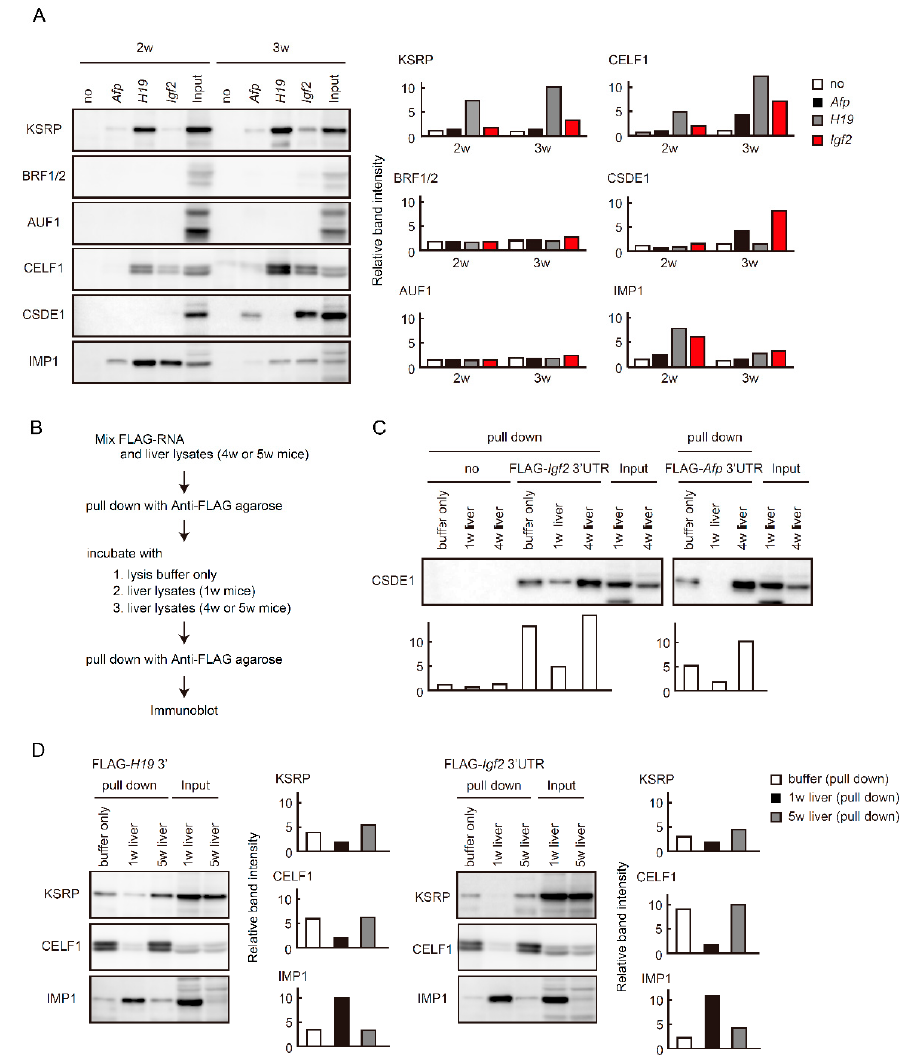
Figure 5. RBPs bind to 3 ′ regions of Afp, H19 , and Igf2 transcripts in a developmental stage-specific manner. ( A ) FLAG-RNAs were incubated with liver lysates from 2 w or 3 w mice. FLAG-RNA-protein complexes were purified and analyzed by immunoblot analyses. Right graphs show quantification of immunoblot data. Relative band intensities to inputs (2 w or 3 w) are calculated ( n = 2). ( B ) Flow of competition experiments. FLAG-RNAs were incubated with liver lysates from 4 w or 5 w mice. FLAG-RNA-protein complexes were purified and then mixed with lysis buffer, liver lysates from 1 w mice, or those from 4 w or 5 w mice. After incubation, FLAG-RNA-protein complexes were purified again. ( C , D ) Final purified proteins as in ( B ) as well as input lysates were analyzed by immunoblot using the indicated antibodies. Graphs below blots ( C ) or on the right of blots ( D ) show quantification of immunoblot data. Relative band intensities to inputs (4 w or 5 w livers) are calculated ( n = 2).